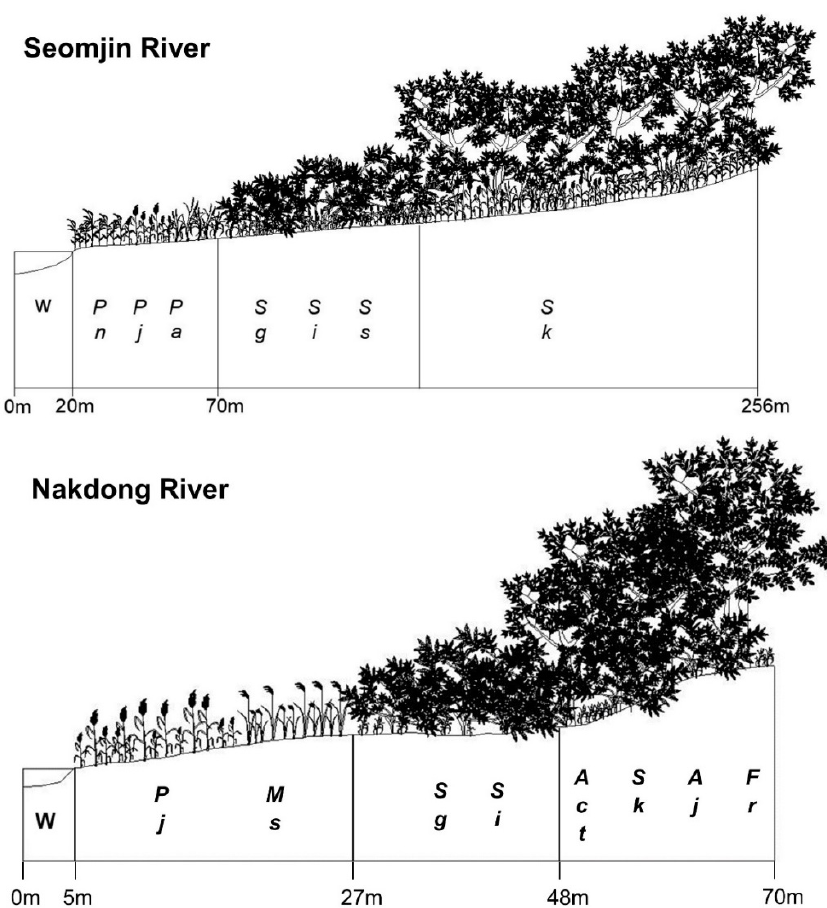
Figure 5. Stand profiles of riparian vegetation collected from the Hantan River, Geum River, Seomjin River, and Nakdong River. Act : Acer tataricum subsp. ginnala ; Aj : Alnus japonica ; Cd : Carex dimor- pholepis ; Fr : Fraxinus rhynchophylla ; Ma : Morus alba ; Ms : Miscanthus sacchariflorus ; Pa : Phalaris arundi- nacea ; Pj : Phragmites japonica ; Pn : Persicaria nodosa ; Pp : Prunus padus ; Ps : Polygonatum stenophyllum ; Sc : Salix chaenomeloides ; Sg : Salix gracilistyla ; Si : Salix integra ; Sk : Salix koreensis ; Ss : Salix subfragilis ; Up : Ulmus pumila ; W: waterway.